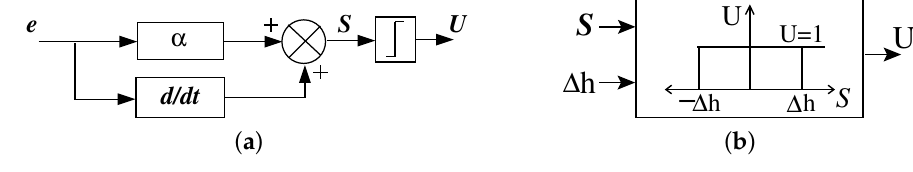
Figure 7. ( a ) SMC block ( b ) Hysteresis